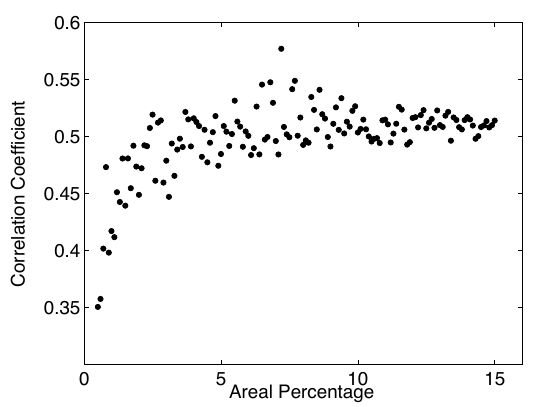
Fig. 2. Correlation coefficients ( y axis) between annual precipita- Figure 2. Correlation coefficients (Y-axis) between annual precipitation time series of 3 tion time series of selected cells from the source sub-basins, as a selected cells from the source-sub-basins, as a function of the areal ratio between selected 4 function of the areal ratio of selected cells to the gauged area of Baltic Sea drainage basin ( x cells and the gauged area of Baltic Sea drainage Basin (X-axis). 5